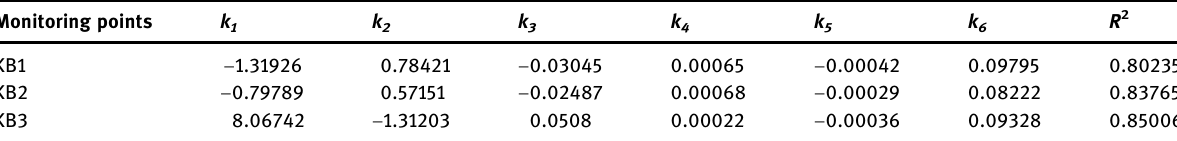
Table 6: UCT fi tting surface parameters Monitoring points